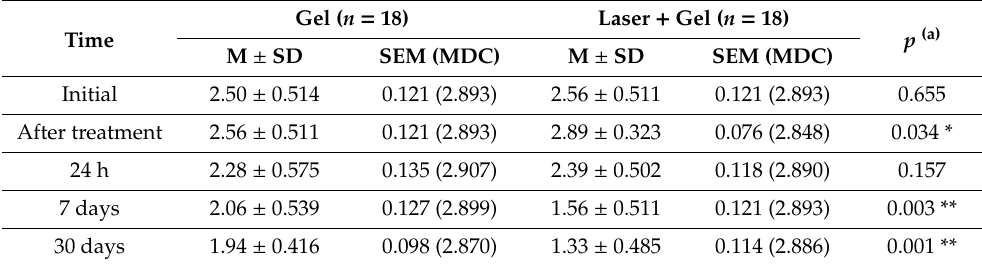
Table 2. Verbal rating scale (VRS) descriptive statistics for the two study groups.